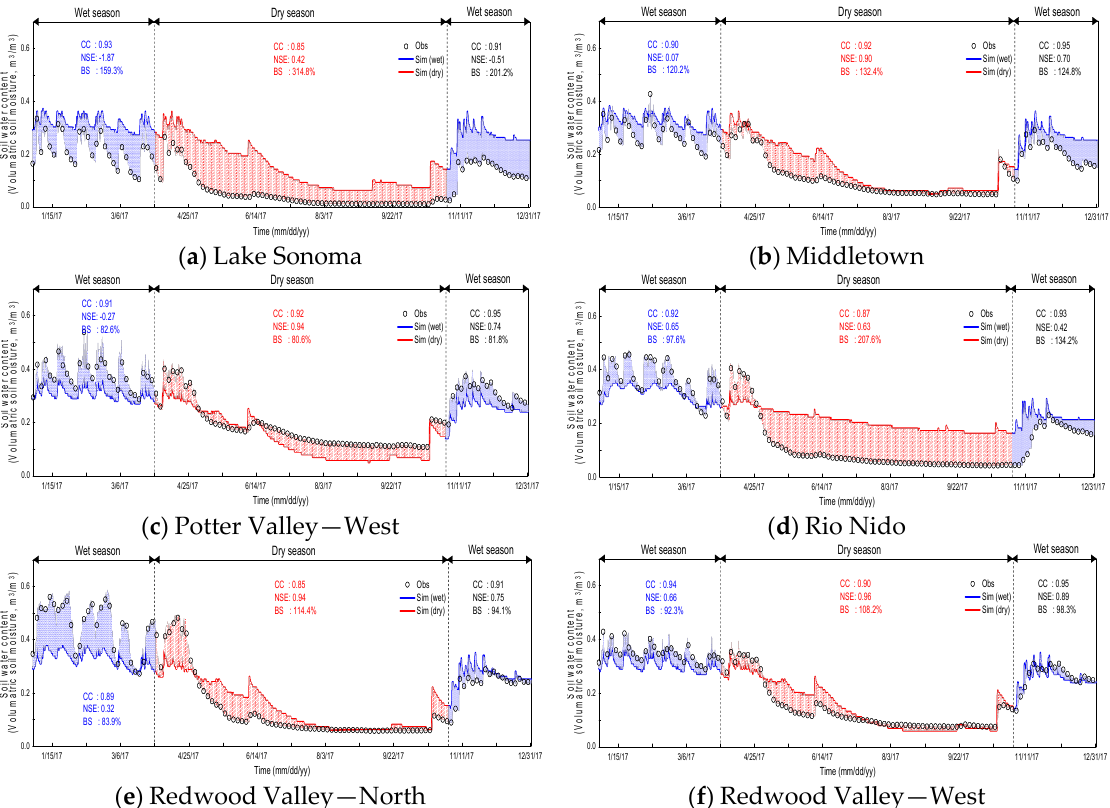
Figure 6. Comparison of three-hourly observed and simulated soil water content data at the six stations for 2017. Blue and red lines mean simulated soil water content during wet and dry seasons, respectively, and dots indicate the observed soil water content data. ( a – f ) are six stations in the Russian River basin listed in Table 2.